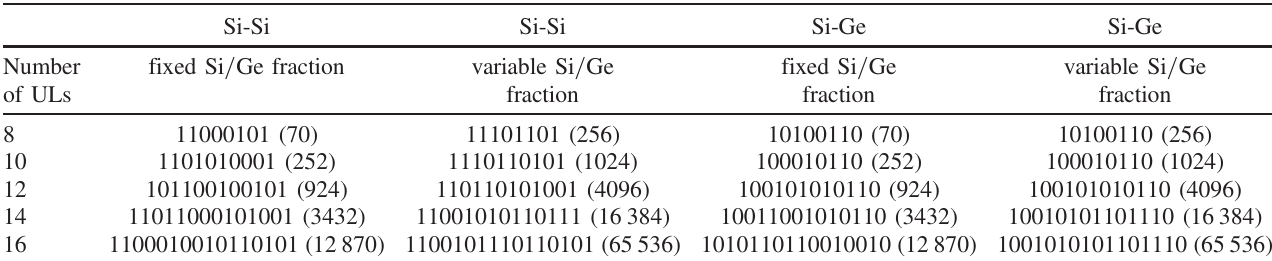
TABLE 1. Optimal superlattice structures obtained through Bayesian optimization for different setups and constraints. The numbers in the brackets are the number of candidates in each case. Thickness of a unit layer (UL) is 5.43 Å. The descriptors “ 1 ” and “ 0 ” describe Si and Ge